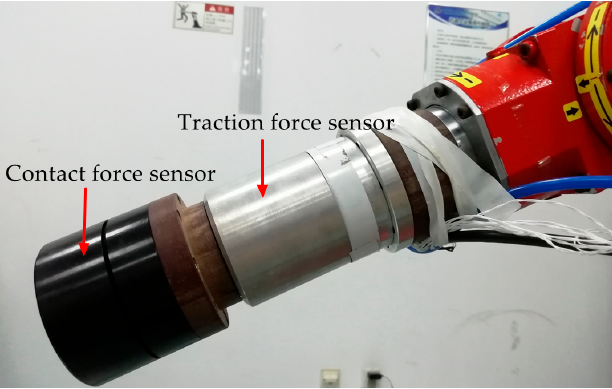
Figure 23. The developed tandem force sensor.